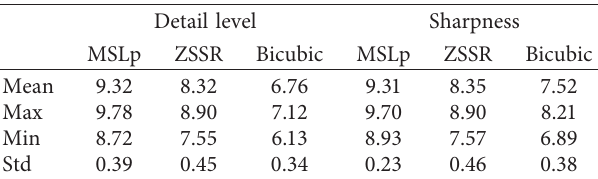
Table 2: Mean opinion score